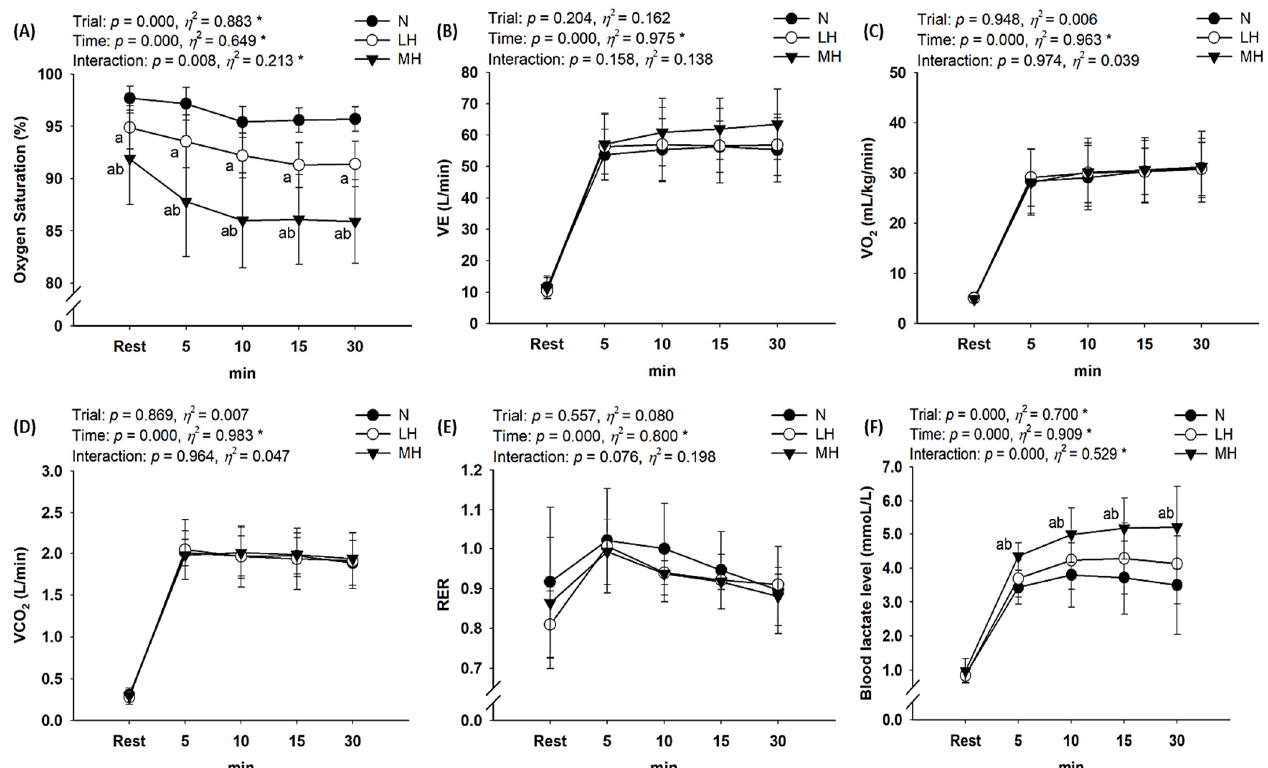
Figure 3. Changes in metabolic parameters at rest and during endurance submaximal exercise. ( A ) S P O 2 , ( B ) VE, ( C ) VO 2 , ( D ) VCO 2 , ( E ) RER, ( F ) blood lactate level. S P O 2 : oxygen saturation; VE: minute ventilation; VO 2 : oxygen uptake; VCO 2 : carbon dioxide excretion; RER: respiratory exchange ratio; N: endurance submaximal exercise under normoxia; LH: endurance submaximal exercise under light hypoxia (596 mmHg, simulated 2000 m); MH: endurance submaximal exercise under moderate hypoxia (526 mmHg, simulated 3000 m). The bars indicate the mean ± S.D. *: Significant interaction or main effect; a: significant difference vs. normoxia; b: significant difference vs. light hypoxia.